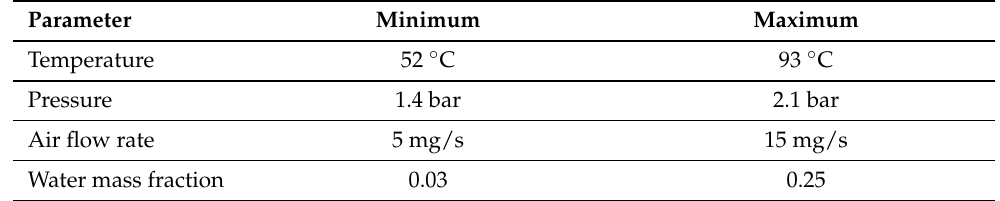
Figure 4. Pair plot of the DoCE samplings and the measurement boundary conditions used for the simulations. The legend applies to all the plots. Table 5. Parameter ranges for simulation of the membrane humidifier. Water mass fraction and relative humidity are applied to the wet inlet only. The air flow rates are scaled to match the model.